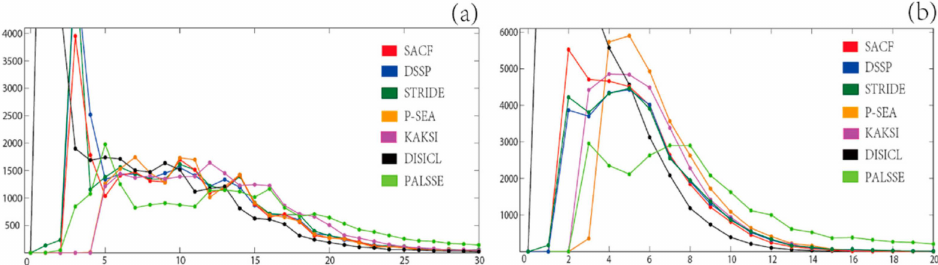
Figure 1. The distribution of the lengths of helices ( a ) and β -sheets ( b ) from SACF and the other six methods on set T . The x-axis represents helix length ( a ) or β -strand length ( b ), while the y-axis represents the number of secondary structures of that particular